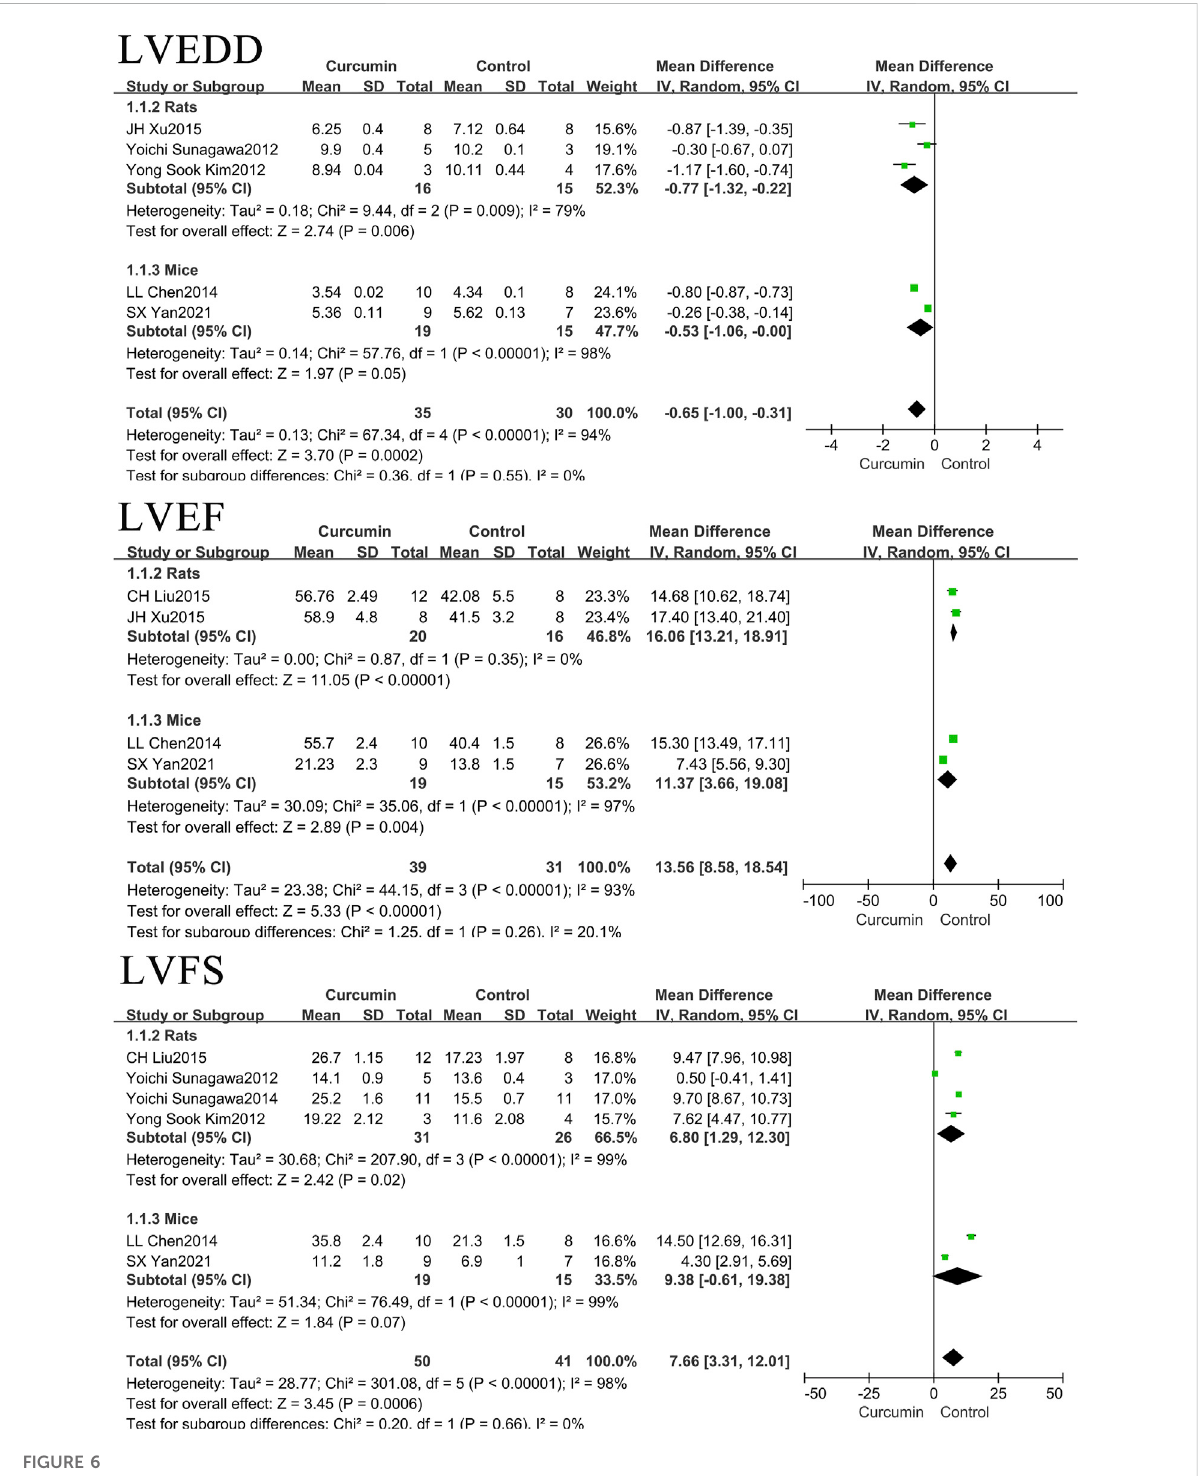
Forest plot of LVEDD, LVEF and LVFS in rats and mice,